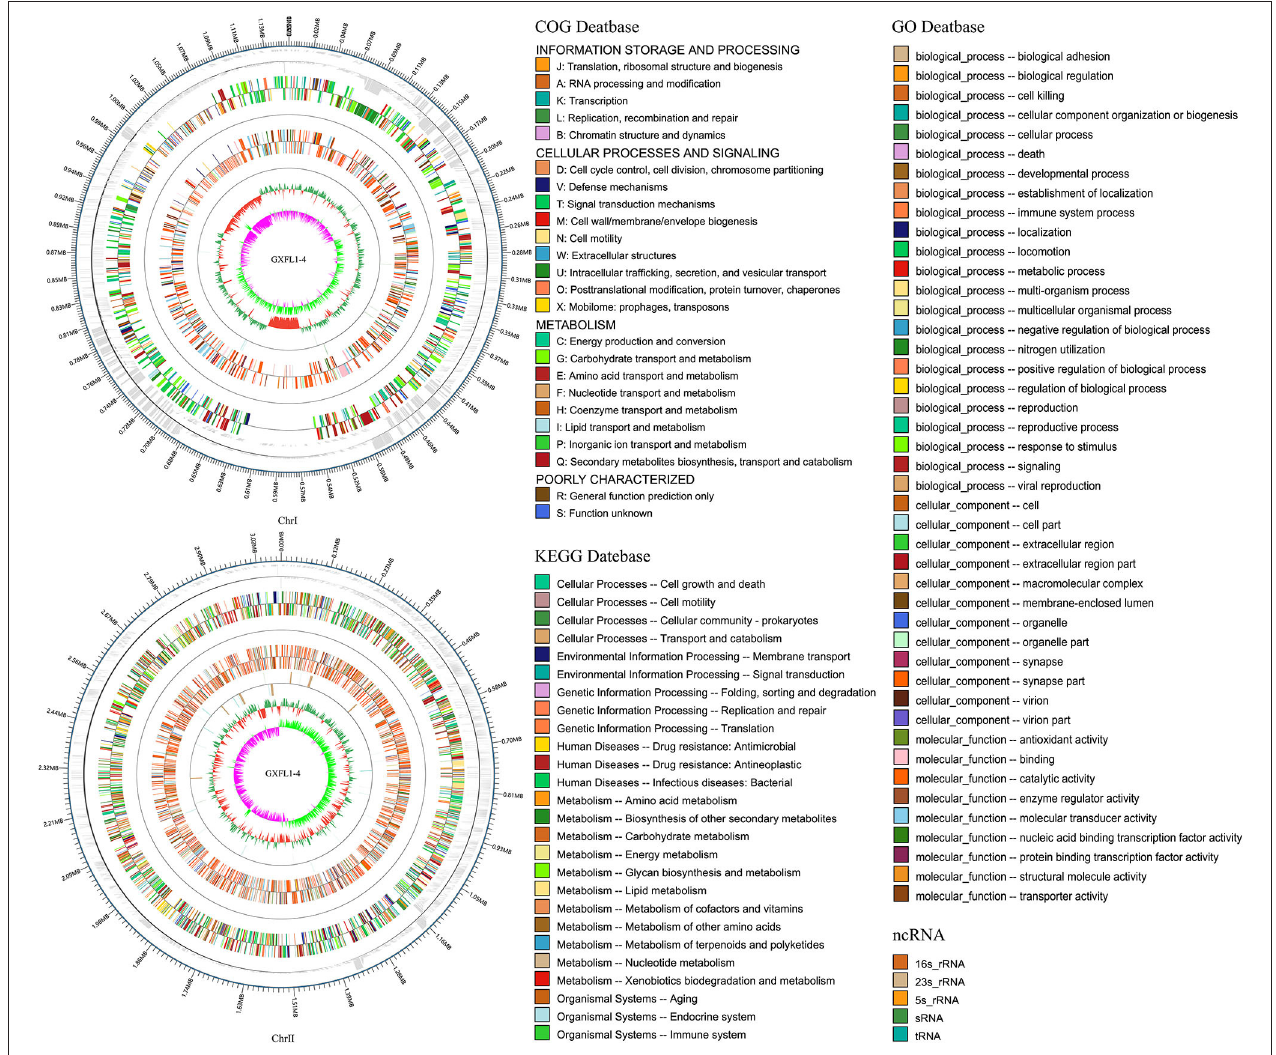
FIGURE 1 | Circular genome map of non-O1/O139 Vibrio cholerae GXFL1-4.